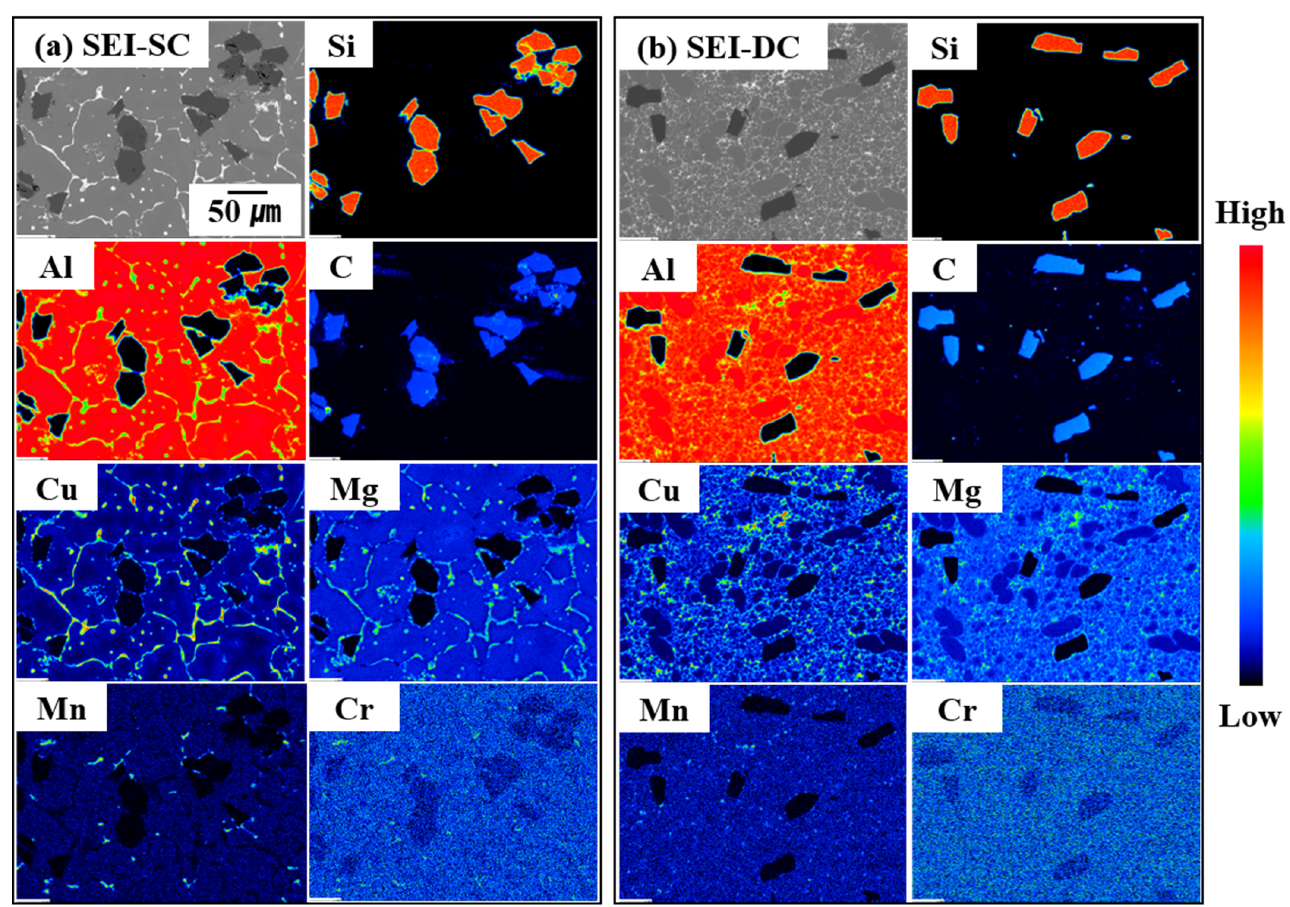
Figure 2. Results of electron probe microanalyzer (EPMA) elemental mapping at 9 vol.% SiC/AA2024: ( a ) SC process, ( b ) DC process.